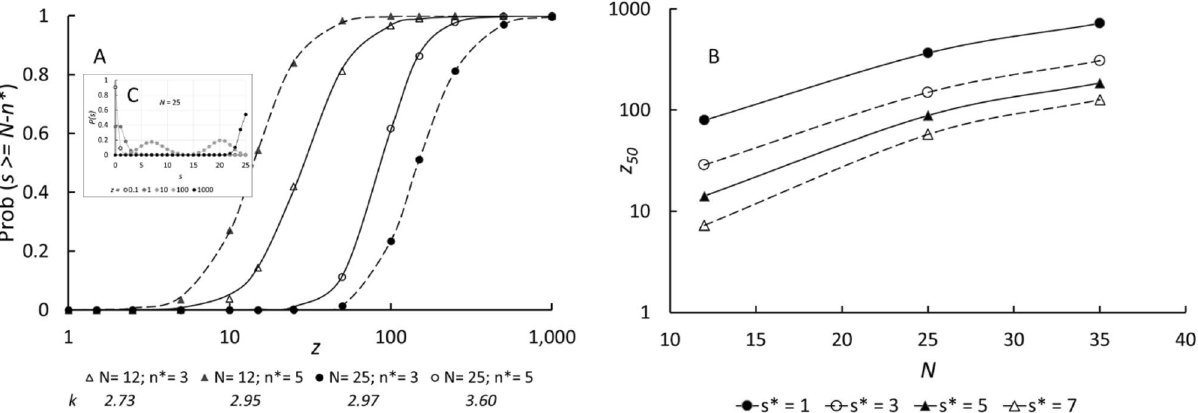
Figure 2. ( A ) Probability of site occupancy, s ≥ N − n *, against dimensionless neutralising antibody concentration, z , for different numbers of spikes on the virus particle, N and various n *; points are calculated with Eq. 8 and lines are fits to the log-logistic function, Eq. 10, with rate parameter k and dimensionless concentration scaling factor z 50 . ( B ) Variation of z 50 with total binding site number, N , and threshold number of vacant sites to allow virus-receptor binding, n *. Inset, ( C ) Individual state probability, P ( s ) against s (Eq. 7) for different z , with N =